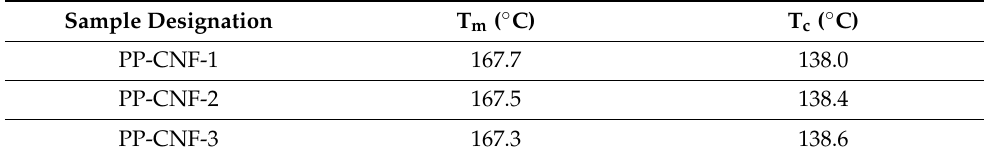
Table 2. Thermal properties of PP-CNF nanocomposites.